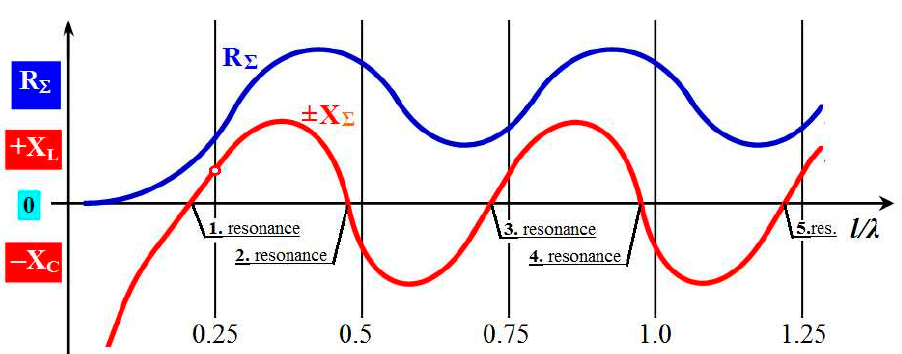
Figure 4. The simplified general course of antenna impedance.